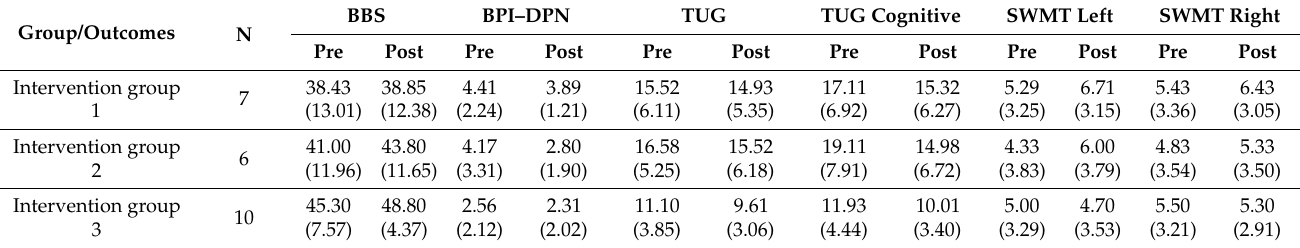
Table 4. Baseline and post-intervention scores for balance, mobility, pain, and sensation for each intervention group. Group/Outcomes